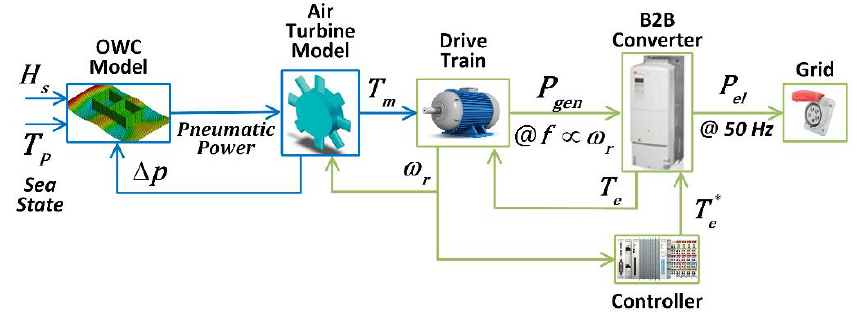
Figure 5. HIL block diagram: the OWC is fully coupled with the turbo-generator.